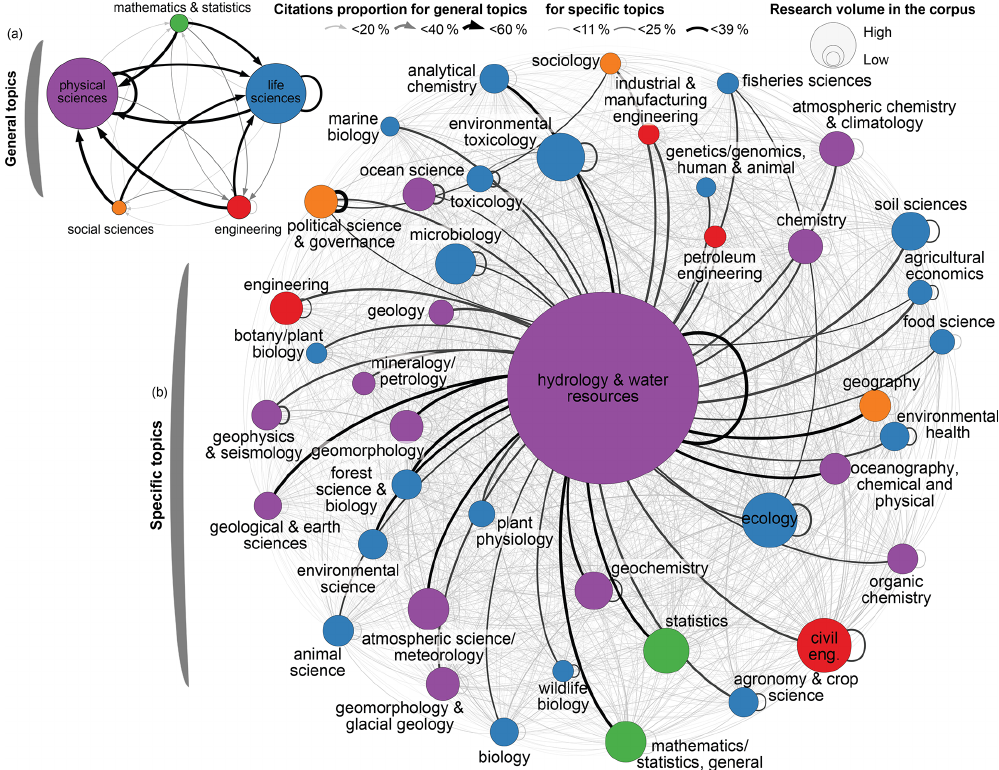
Figure 10. Connectivity between topics of research, measured by directional citations between articles’ research topic for (a) general topics and (b) specific topics. The direction of each edge is represented by drawing it clockwise from an earlier node to a later